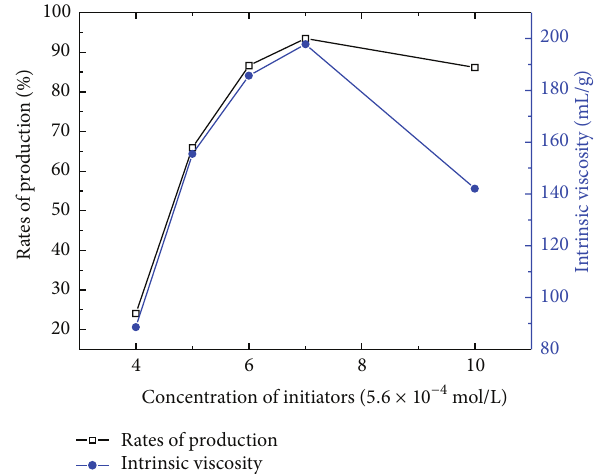
Figure 5: Effects of concentration of initiators on intrinsic viscosity and rates of production.